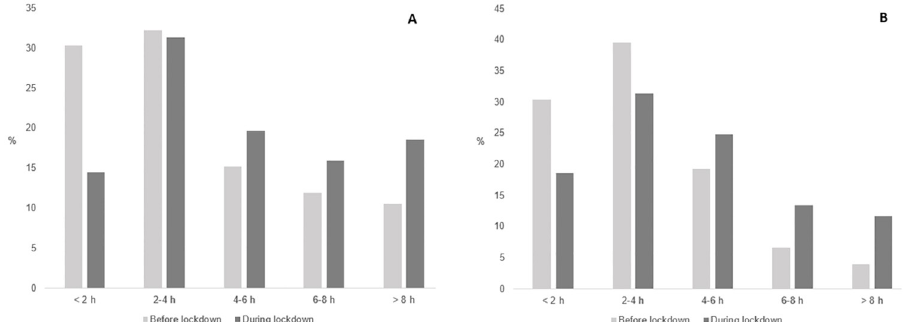
Fig 2. Screen time on weekdays (A) and weekend days (B) before and during